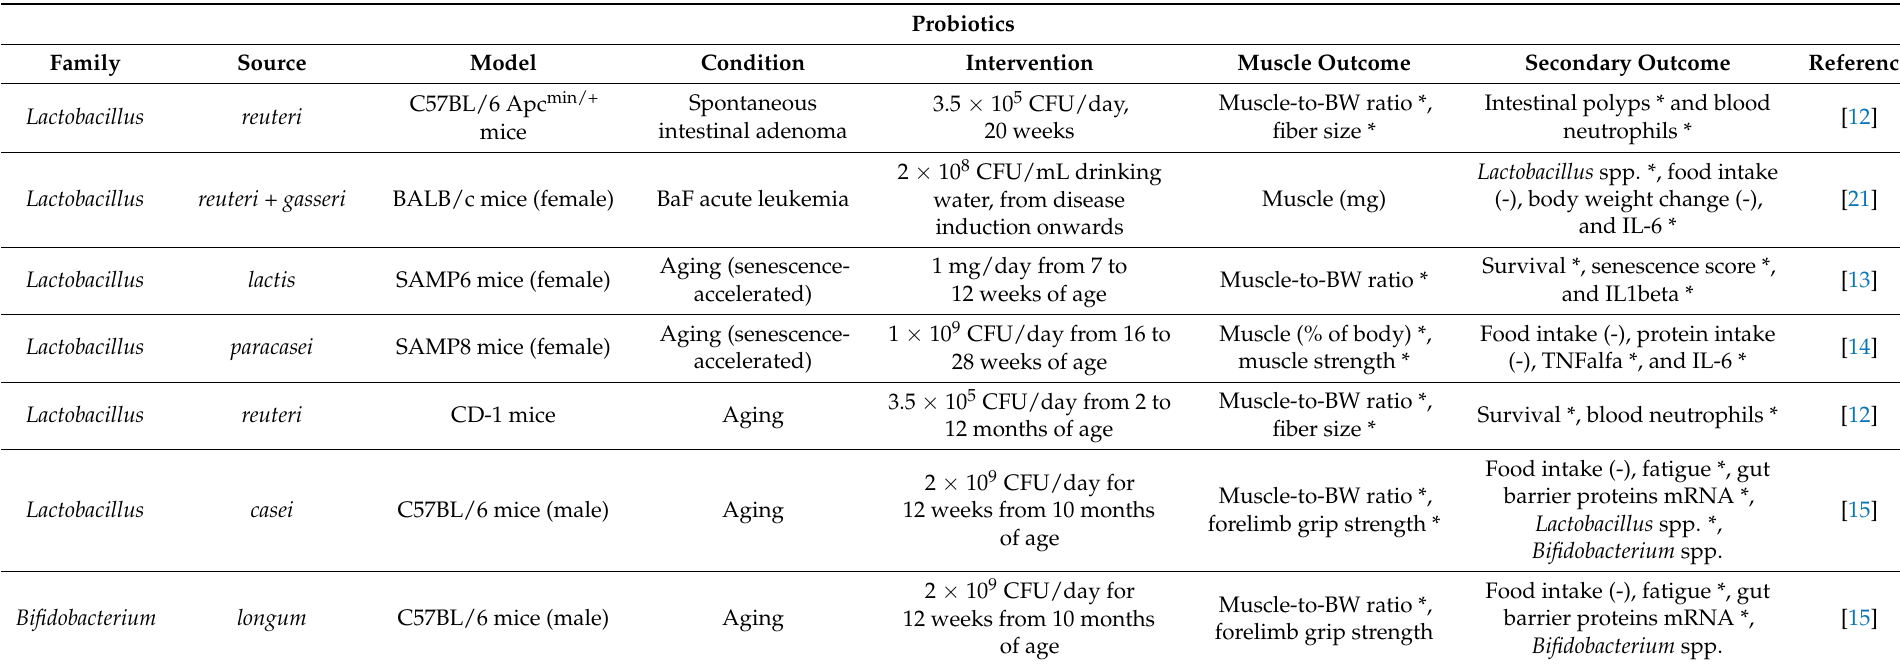
Table 1. Characteristics and results of the studies included in the systematic research on the effects of pre-, pro- and synbiotics on